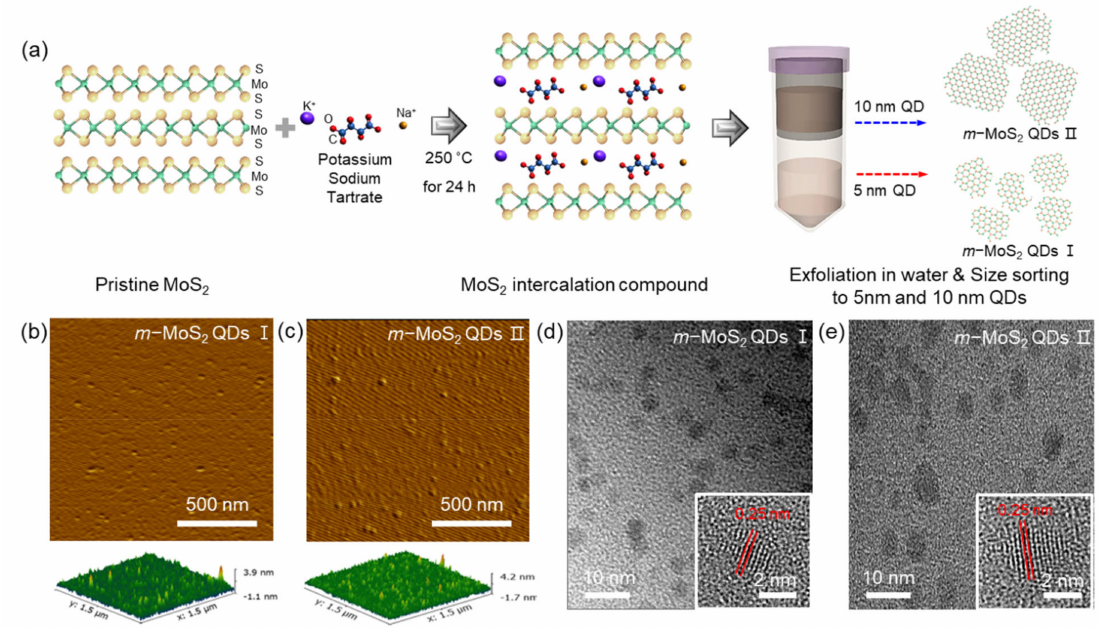
Figure 1. Schematic illustration and characterization of m -MoS 2 -QD I and m -MoS 2 -QD II ( a ) Fab- rication steps of m -MoS 2 -QD I and m -MoS 2 -QD II. ( b , c ) AFM images. ( d , e ) HR-TEM images of m -MoS 2 -QD I and m -MoS 2 -QD